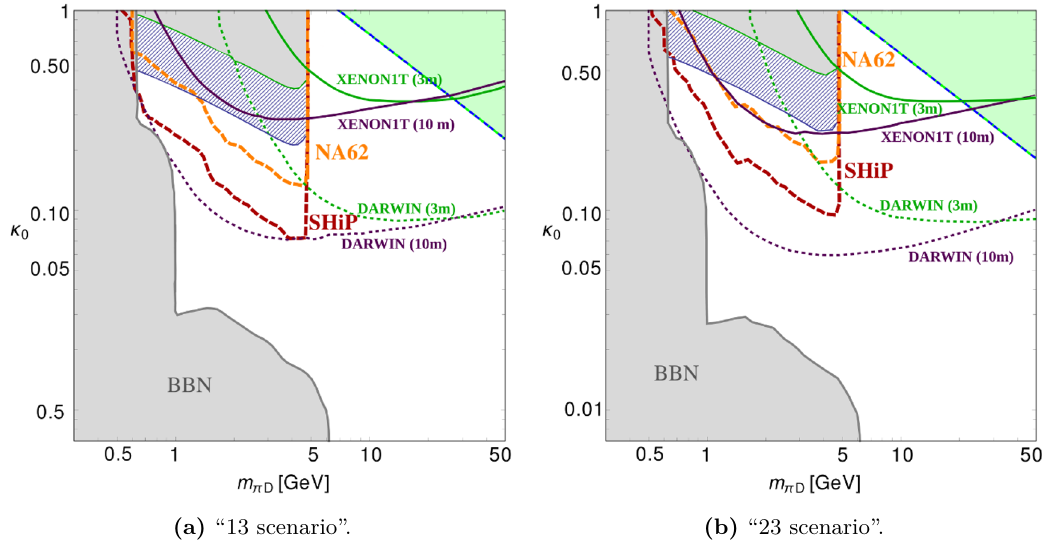
Figure 11. Constraints on dark QCD in the m p the dashed dark red (orange) line more than 3 dark pion decays are expected over the full run in SHiP (NA62 in beam-dump mode). In green ( m p (solid) and projected (dotted) dark matter direct detection bounds. The grey region is disfavoured from BBN or flavour constraints. In the blue hatched region the upcoming measurements of Belle II for Br ( B → K ¯ νν ) is expected to be sensitive [25–27]. The region above the blue-green line will be probed by future emerging jets searches, while below the MET search should be most